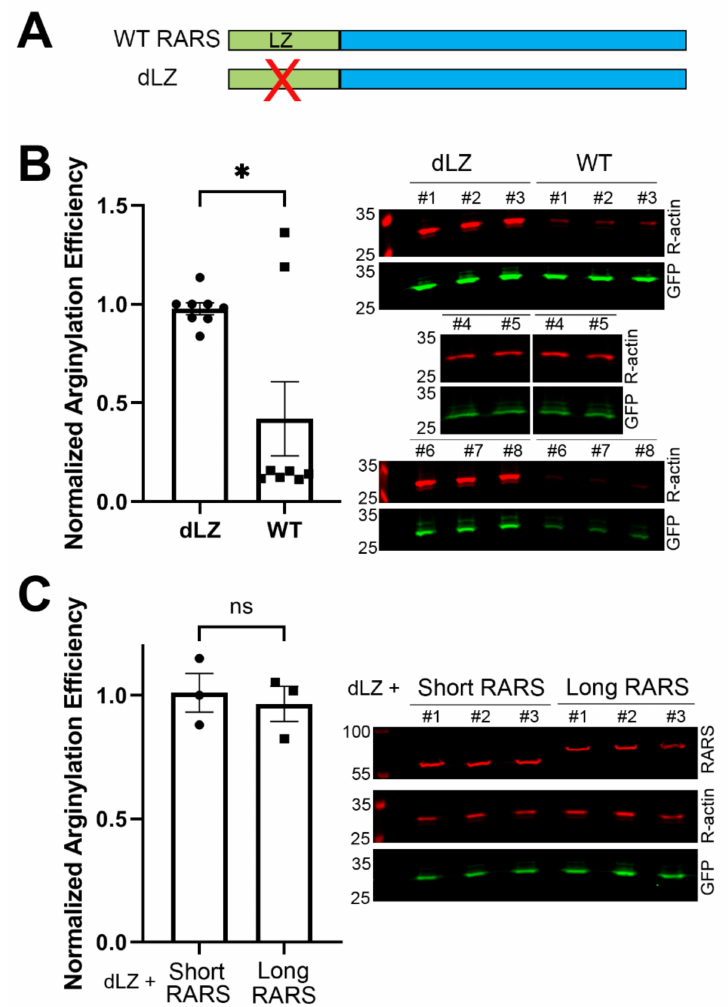
Figure 5. Displacement of the long RARS from the multi-synthetase complex increases intracellular arginylation. ( A ) Diagram representing the deletion of the leucine zipper (LZ) in dLZ cells to convert the entire RARS into the cytosolic soluble pool. ( B ) Chart and representative immunoblots of arginylation sensor quantification in HEK293T cells produced by knocking out the leucine zipper domain in the long RARS to displace it from the multi-synthetase complex (dLZ) compared with the parental cell line (WT). Cells of similar confluency were chosen as pairs for quantification. Error bars represent the SEM; n = 8. * p < 0.05, Welch’s t -test. ( C ) Chart and representative immunoblots of arginylation sensor quantification in dLZ cells transfected with the long or short RARS. Error bars represent the SEM; n = 3 biological replicates. ns, not significant, Welch’s t